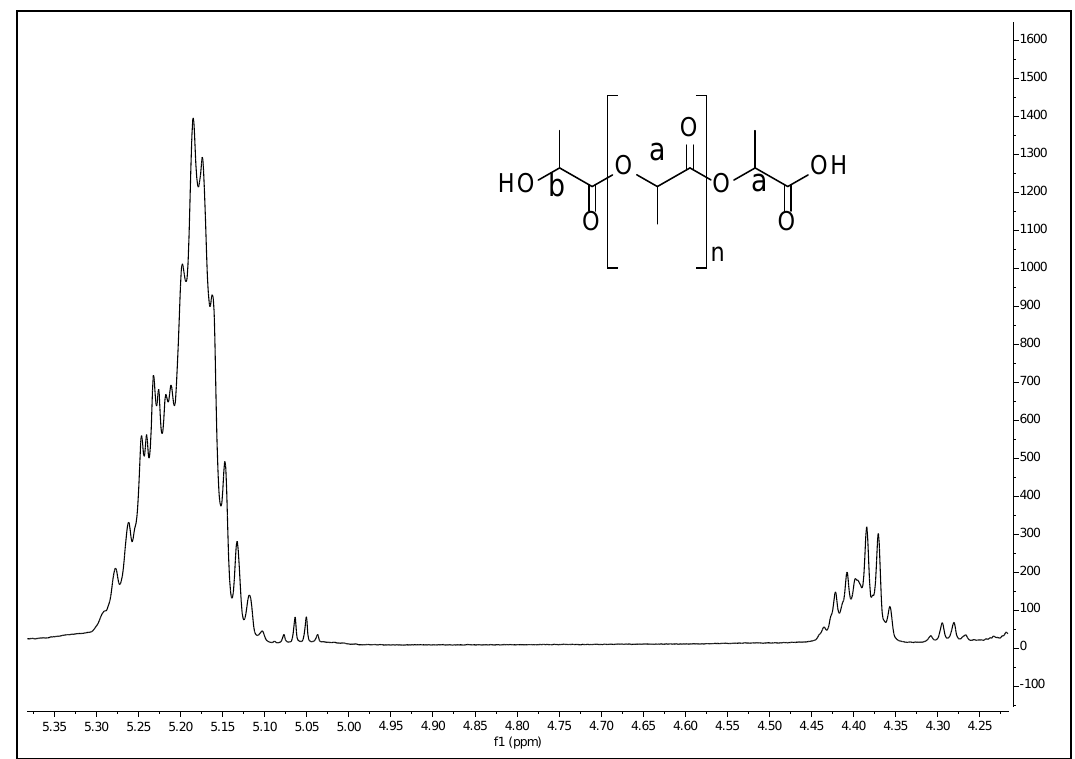
Figure 6. 1 H NMR (500 MHz) spectrum in CDCl 3 for the poly(lactic acid) ( M n (NMR) aprox = 1440).